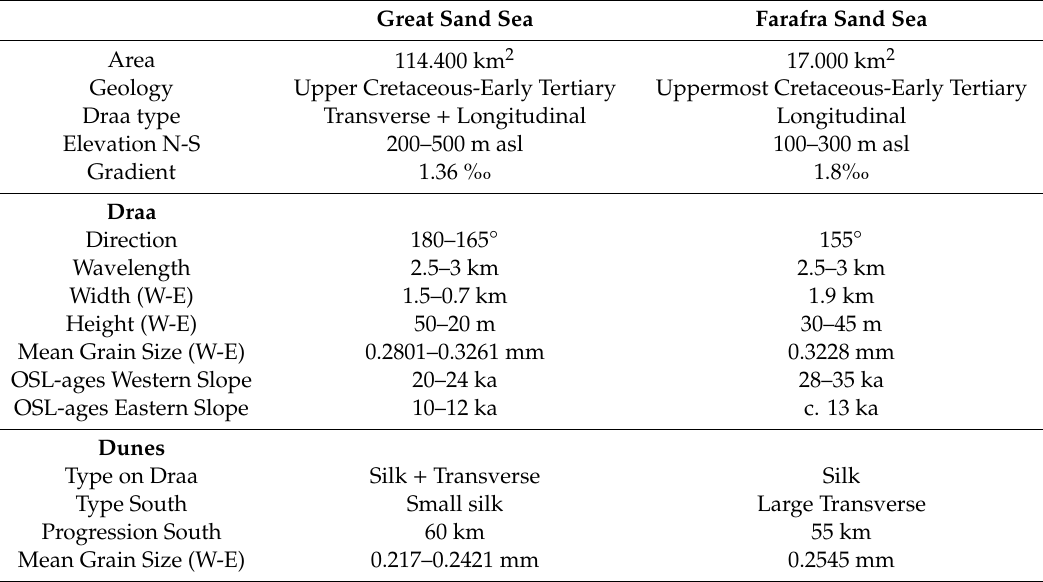
Table 2. Comparison of characteristic features of the Great Sand Sea and the Farafra Sand